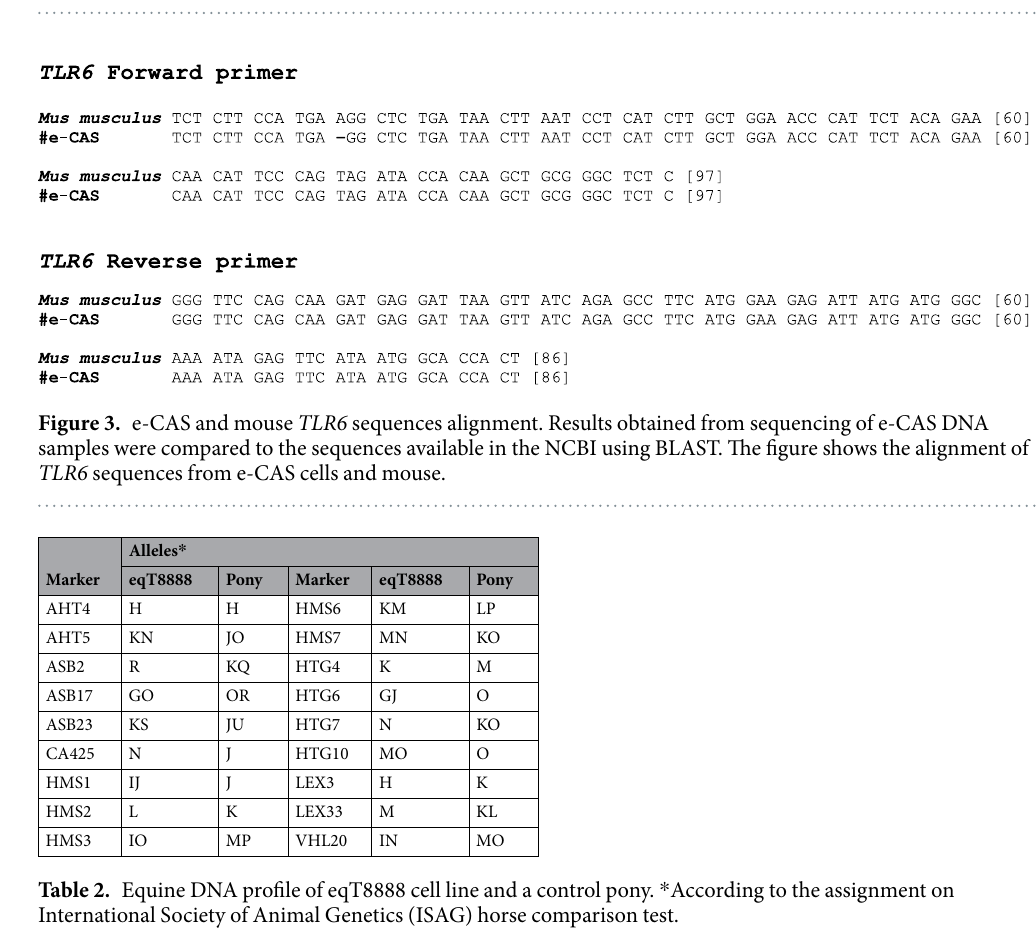
Figure 2. TLR6 sequences alignment. Results obtained from sequencing of e-CAS, eqT8888, P1 and P2 DNA samples using the primers forward (top) and reverse (bottom) primers for the TLR6 reaction. SNPs are in bold.